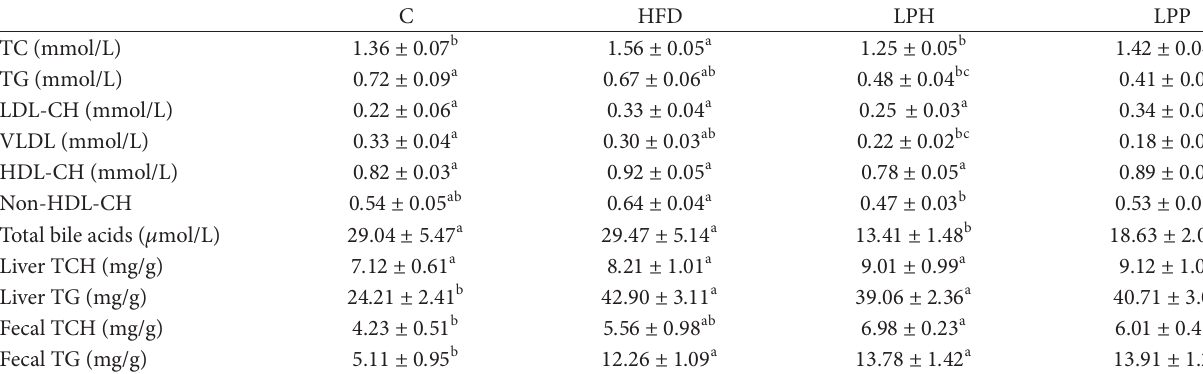
Table 3: Lipid parameters and non-HDL cholesterol.